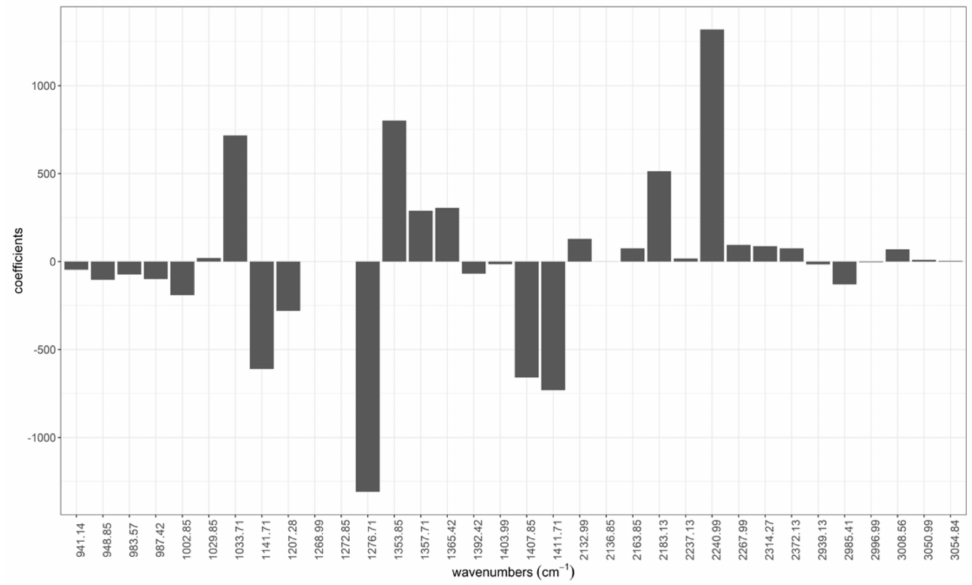
Figure 3. Coefficients selected by the lasso method for the quantification of the adulterant using the FT-IR spectrum of the adulterated juice